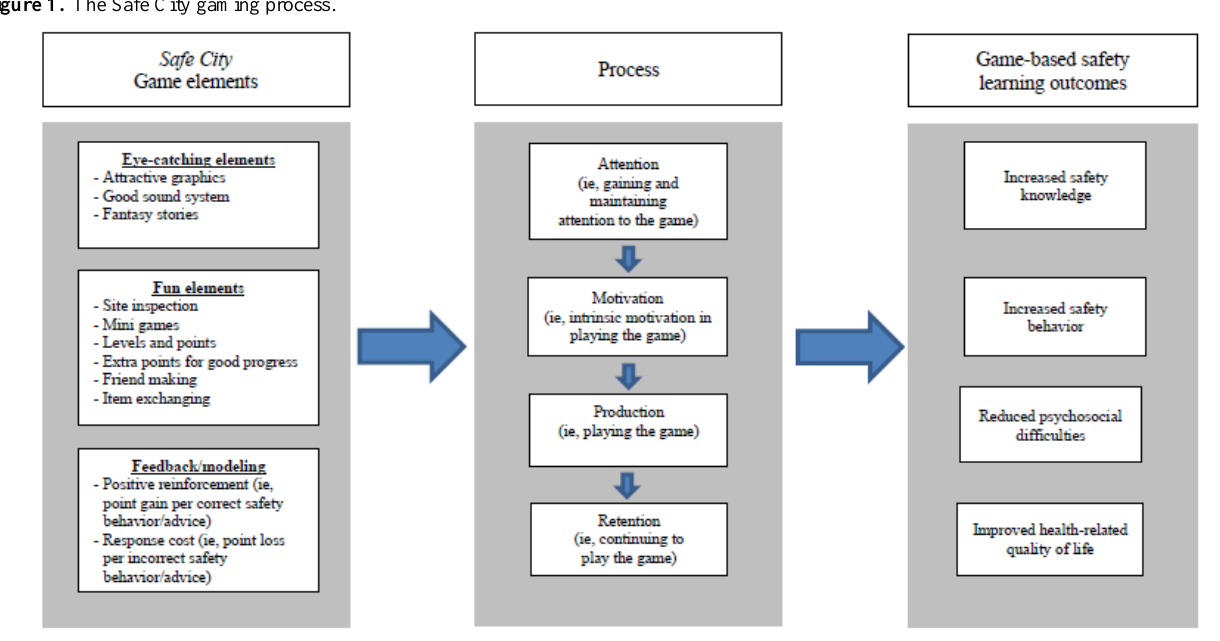
Figure 1. The Safe City gaming